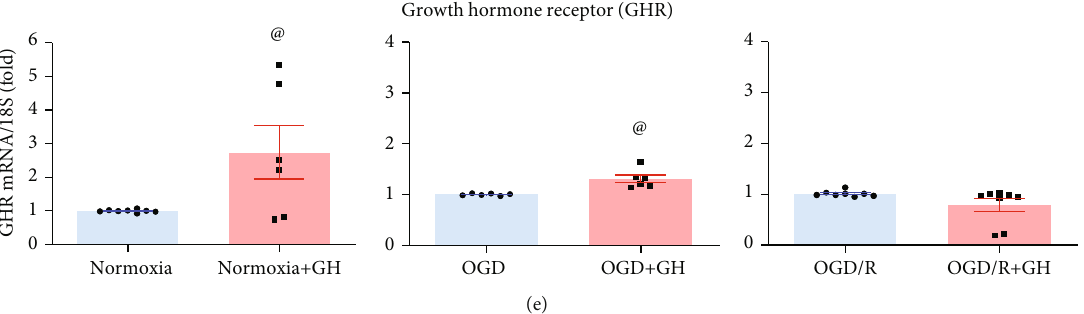
Figure 9: E ff ects of growth hormone (GH) upon BDNF, IGF-1, NT-3, BMP4, and GHR mRNA expression during OGD and reoxygenation (OGD/R) conditions. Panels show the relative expression of (a) BDNF, (b) IGF-1, (c) NT-3, (d) BMP4, and (e) GHR mRNAs, in each group: (i) normoxia, (ii) OGD, and (iii) OGD/R, as determined by RT-qPCR. Relative mRNA expression values were corrected by the comparative threshold cycle (Ct) method and employing the formula 2 − ΔΔ CT . Ribosomal 18S RNA was used as housekeeping gene. Bars represent mean ± SEM . The at sign (@) indicates signi fi cant di ff erences in comparison to control (@ p < 0 : 05 ; @@ p < 0 : 01 ) assessed by unpaired Student ’ s t